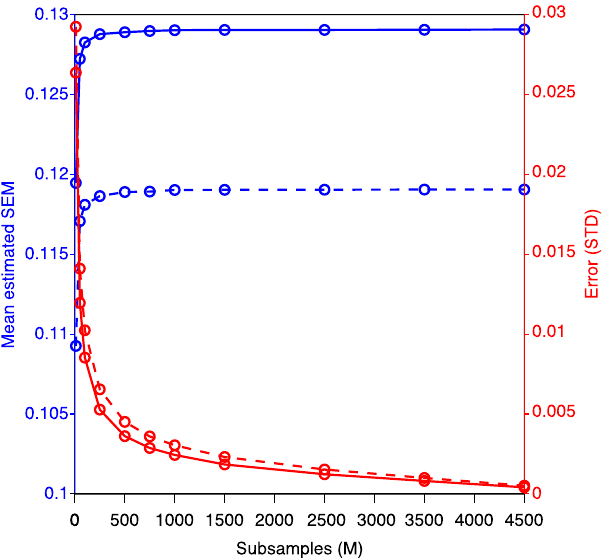
Figure 5. Average Estimated Standard Error of the Mean and Estimator Variance as a Function of Subsample. Average estimated standard error for M1 (solid blue curve) and M2 (dashed blue curve) as a function of subsamples. The estimate stabilizes above a subsample size of 250. The variance of the estimator for M1 (solid red curve) and M2 (dashed red curve), estimated over 10000 random subsamples for each level of M, monotonically decreases with subsample size quickly becomes negligible as M